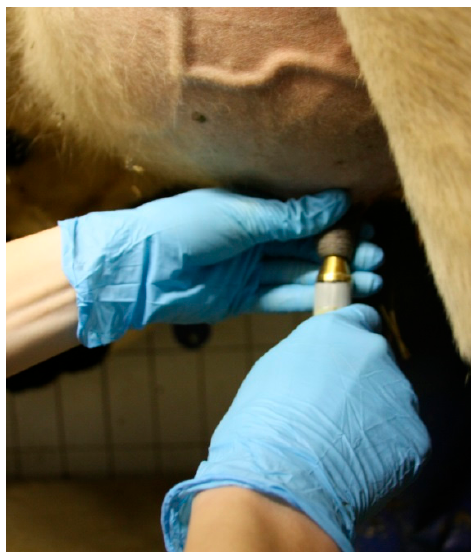
Figure 2. Measuring the dielectric constant at the teat orifice.